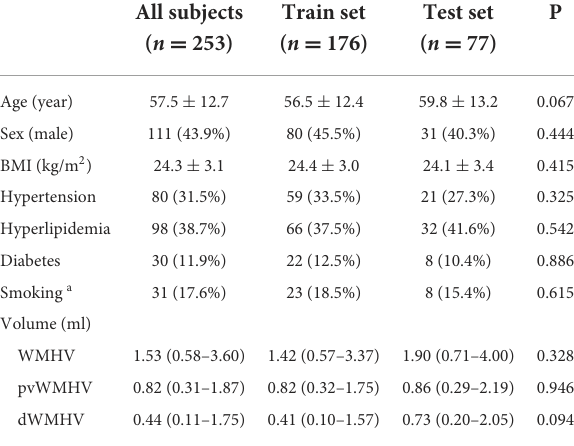
TABLE 1 Clinical characteristics of the study